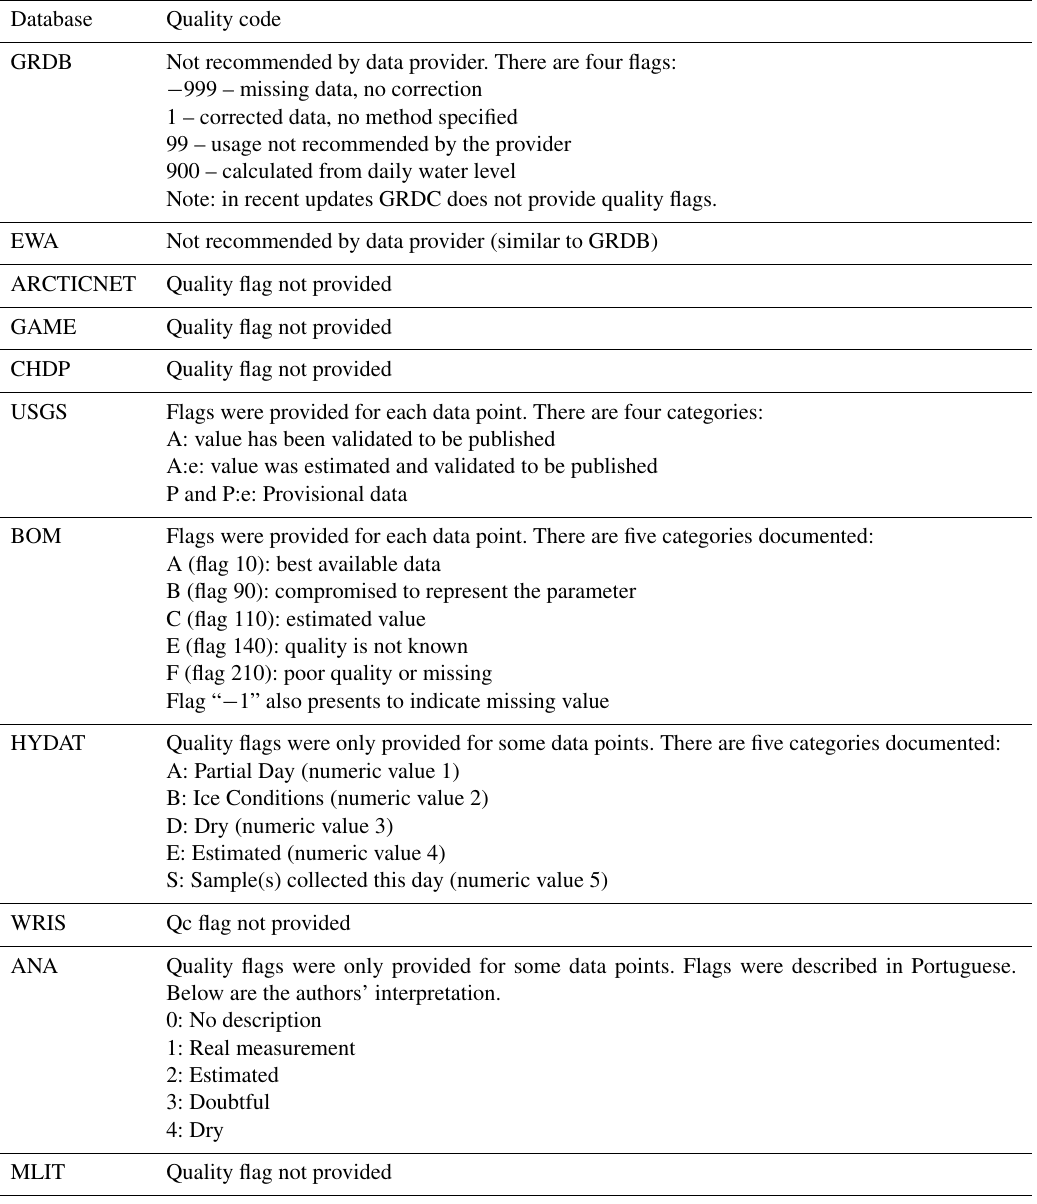
Table 1. Quality flags of daily values of all databases that enter the GSIM collection (see Do et al., 2018a). Database Quality